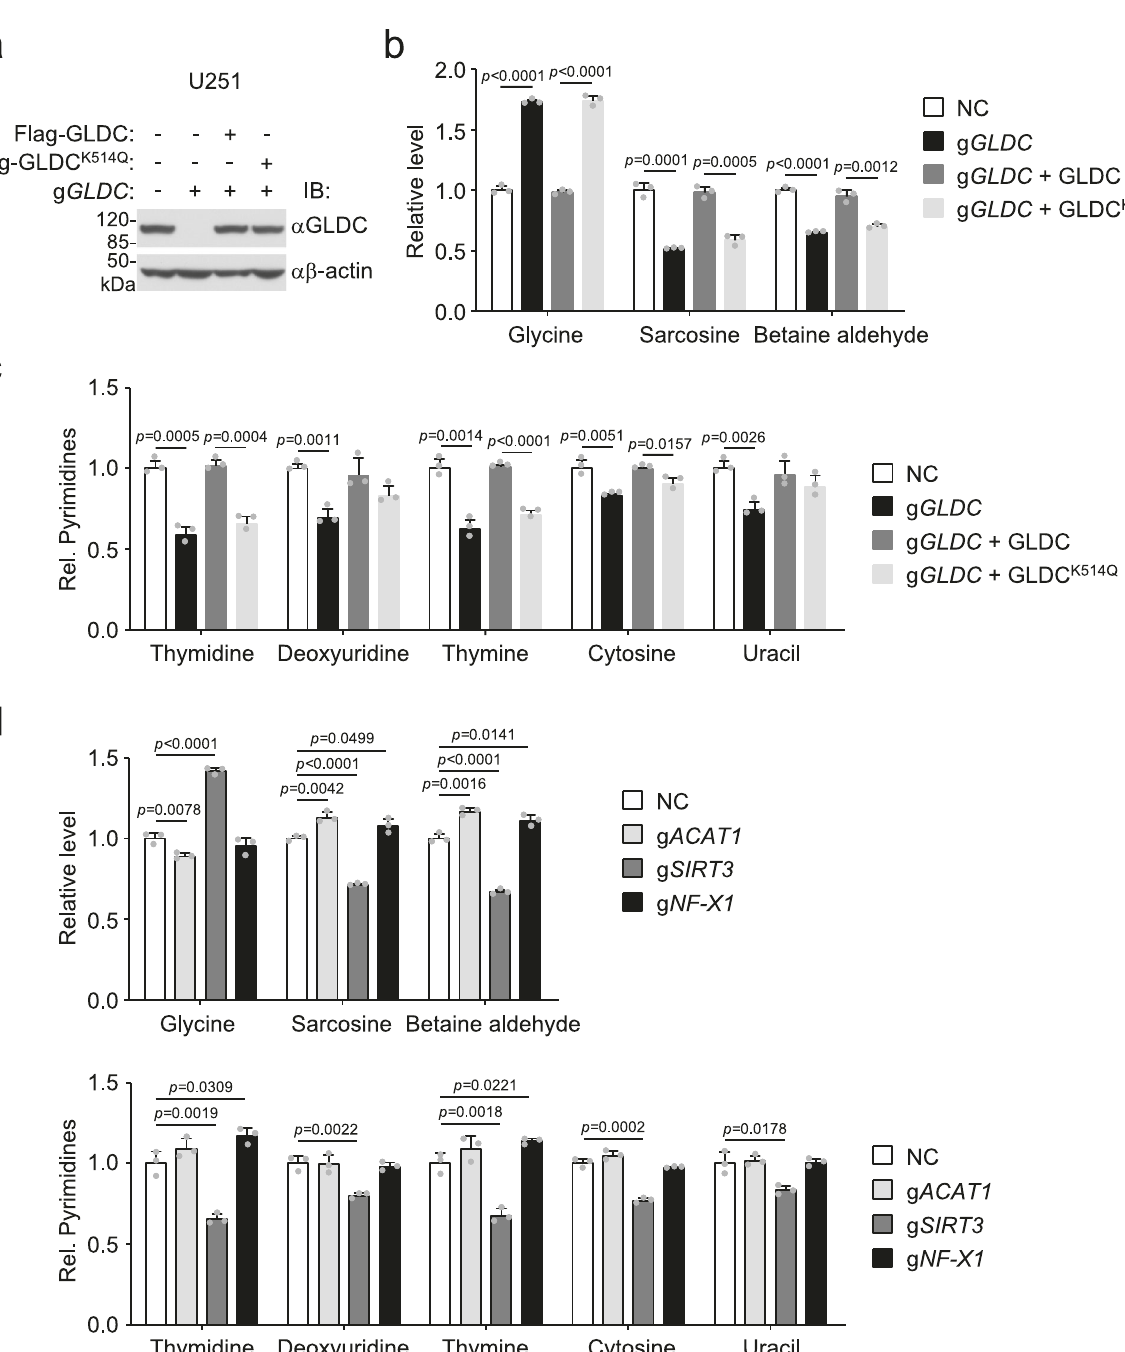
bicarbonate carbon 32 . The standard assay mixture, in a total volume of 300 μ l at 30 °C, contains 100 mM sodium phosphate (pH 6.0), 0.1mM PLP, 18mM glycine, 1 mM DTT, 5 μ g H protein, 2.5 μ g GLDC protein, and 30mM 13C-NaHCO 3 . All rates were corrected by control reactions without glycine. All enzyme assays were done in triplicates and repeated at least once with independent protein prepara- tions. Immediately after starting the reactions by the addition of 13C-NaHCO 3 for a total time of 20 min, aliquots of 200 μ l were mixed with 20 μ l of trichloroacetic